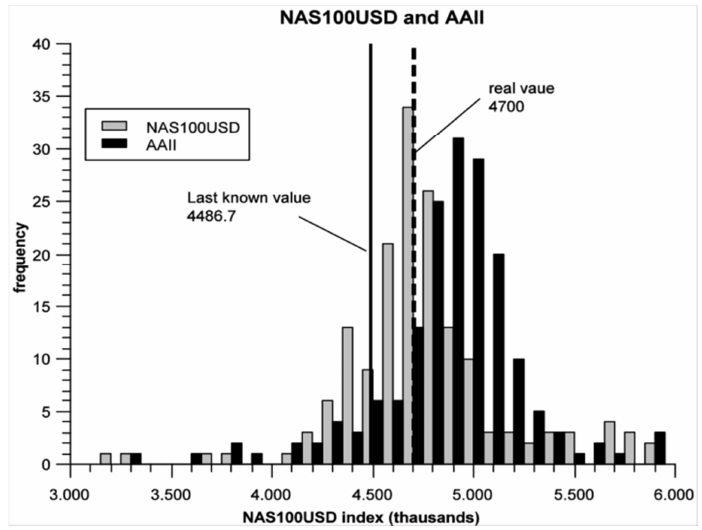
Figure 7. Combination of the NAS100USD index and individual investors’ sentiment (AAII)